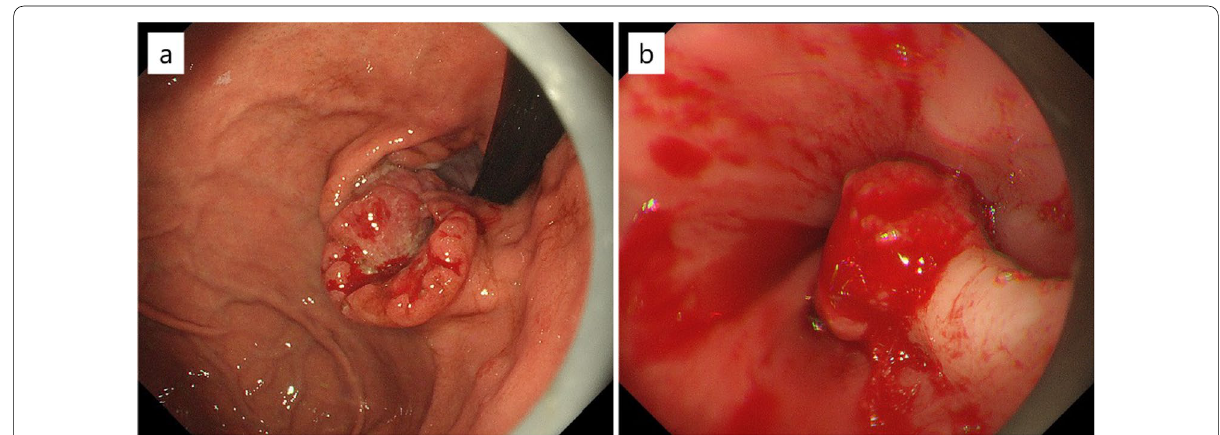
Fig. 1 Gastroduodenal endoscopy findings. a A 5 cm type 2 tumor was found at the cardia side of the esophagogastric junction. b The tumor